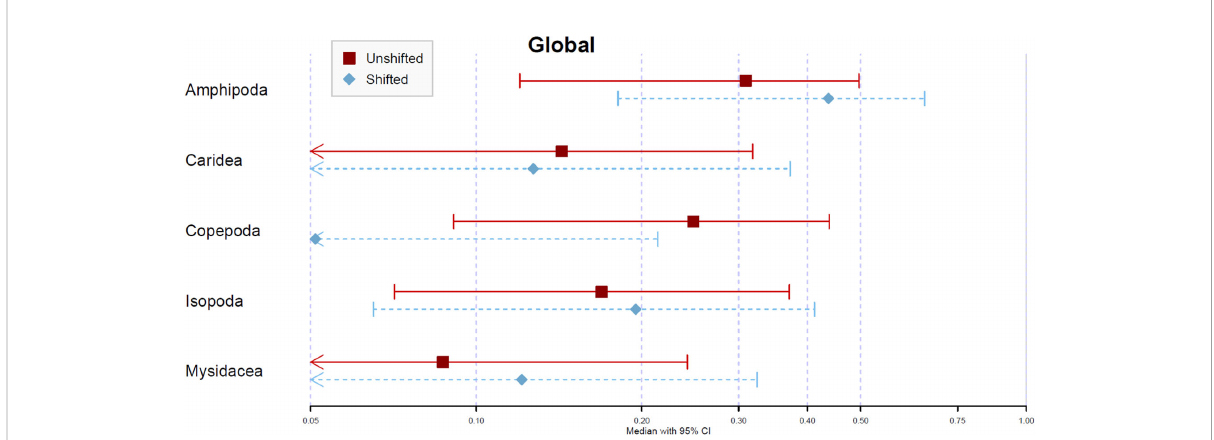
FIGURE 5 Global assessment – Average posterior proportional contribution for S. acus as estimated by Bayesian Stable Isotope Mixing Model (SIMM). Analyses based on isotopic ( d 13 C and d 15 N) data for dorsal fi n tissues of 110 fi shes sampled in C ı ́ es Archipelago in 2017 (summer and autumn) and 2018 (spring, summer and autumn). Treatments: average isotopic values of potential sources sampled concomitantly with consumers (Unshifted) or in the previous season of consumer sampling (Shifted). Symbols represent the median contribution of each key source with 95% (lines) credible